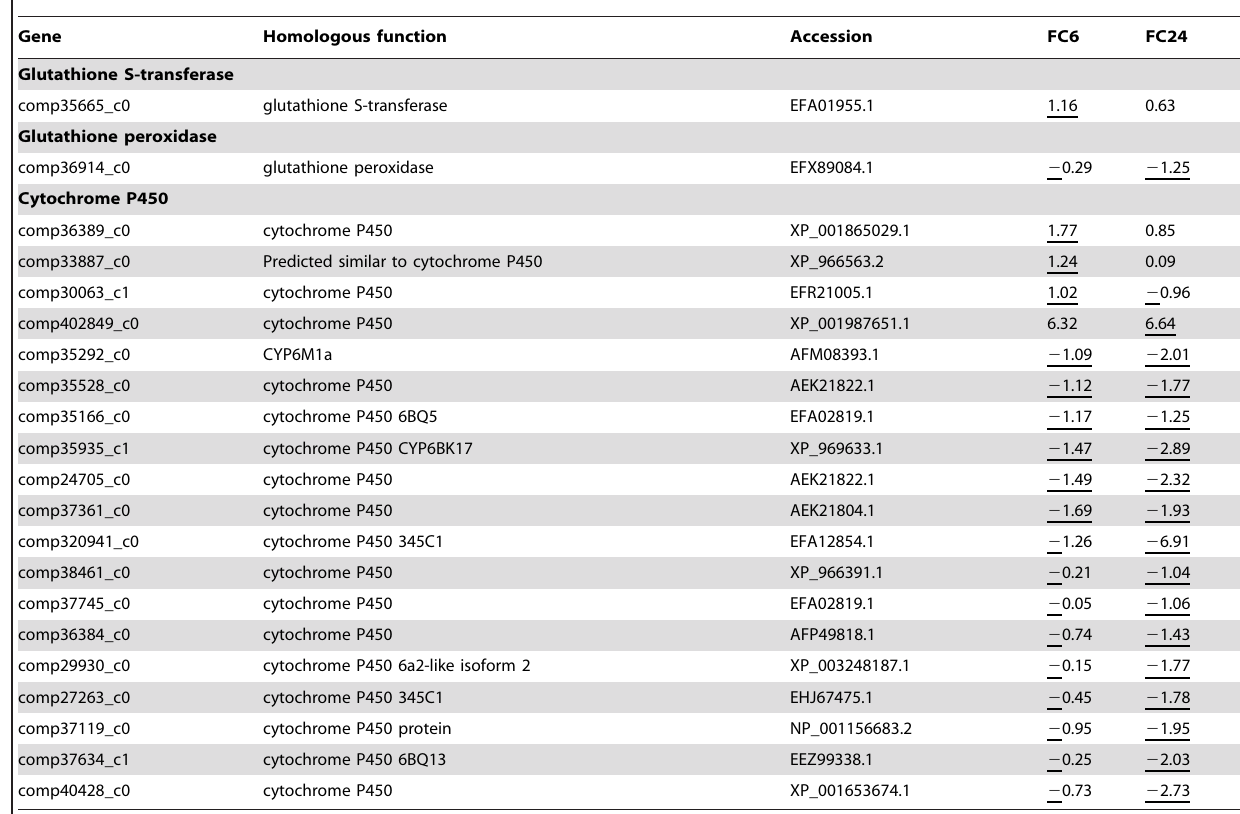
Table 5. Differentially expressed detoxification enzymes.